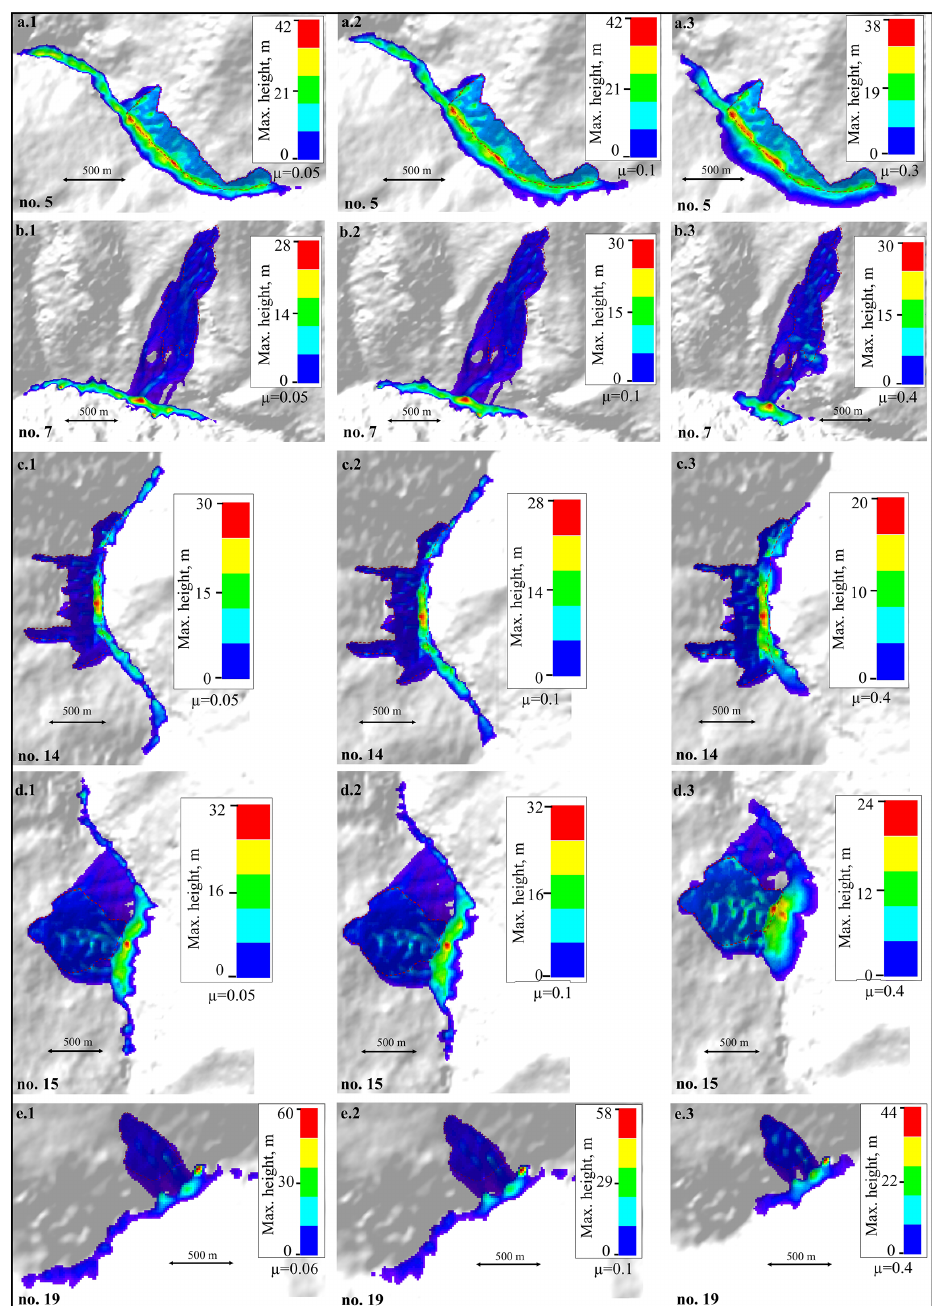
Figure 13. Results of the run-out analysis. µ refers to the coefficient of friction.